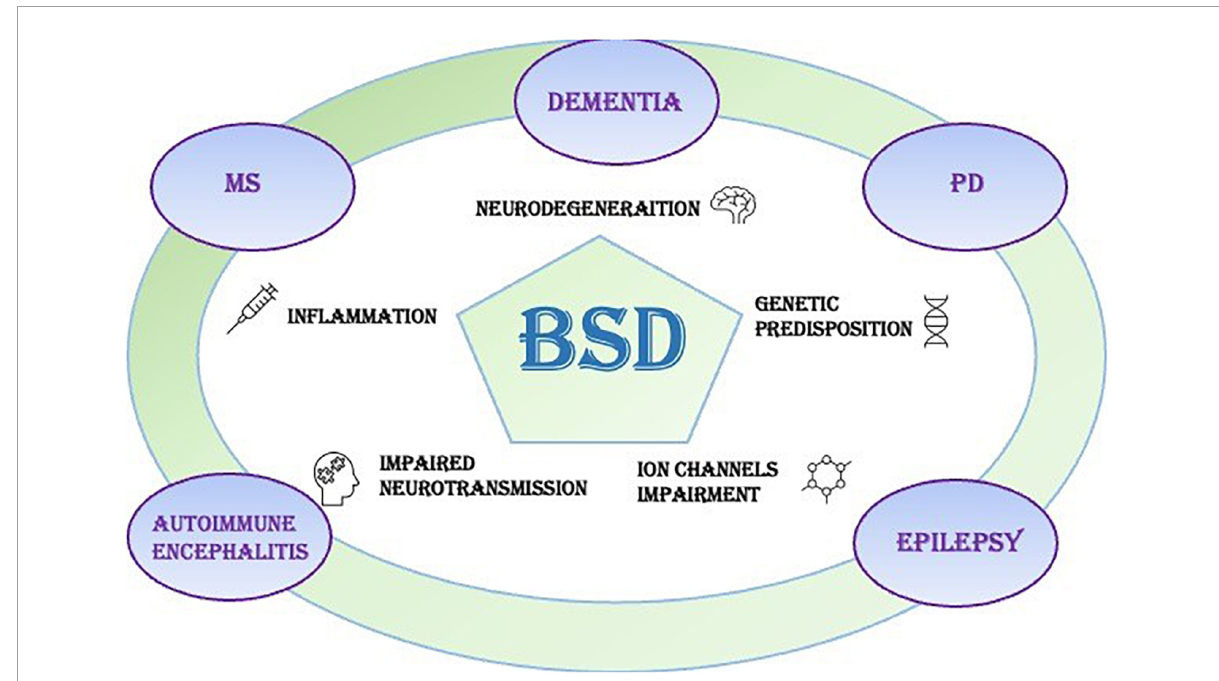
FIGURE1 Bipolar spectrum disorders (BSDs) frequently occur in neurological disorders of the central nervous system, like dementias, Parkinson’s disease (PD), multiple sclerosis (MS), autoimmune encephalitis (AE), and epilepsy. The pathophysiological triggers of the neurological symptoms can play a role also in the onset of mood disorders like